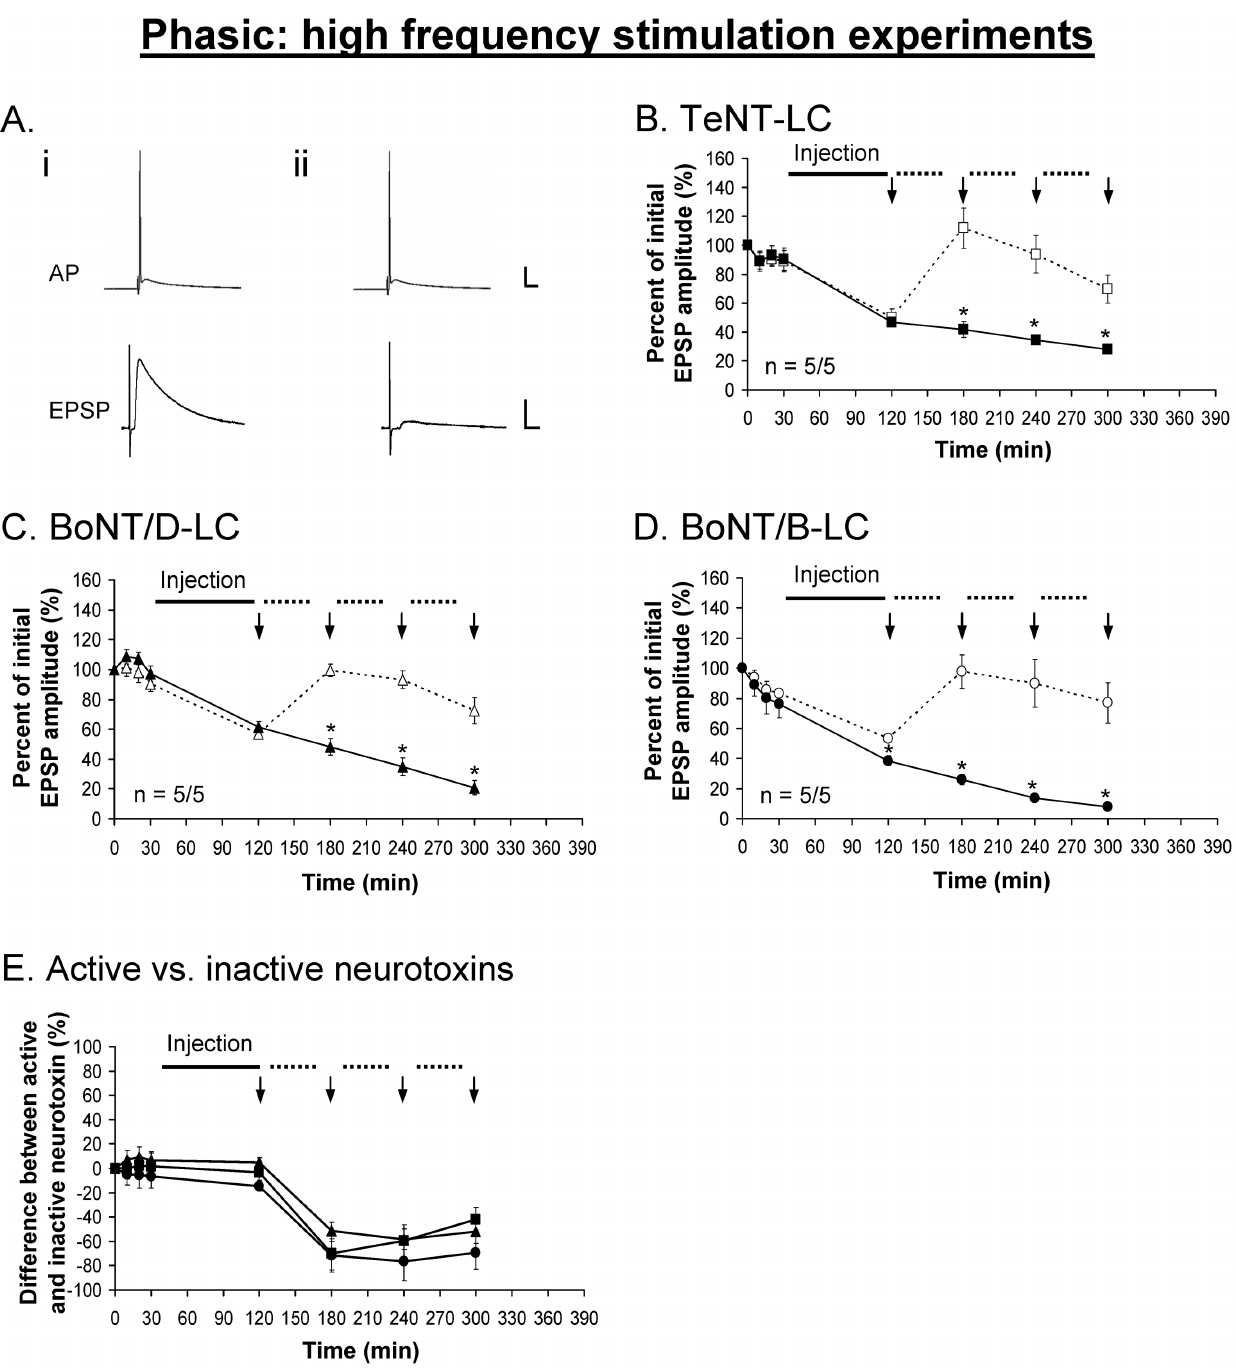
Figure 6. Phasic EPSPs are inhibited using TeNT-LC ( B ), BoNT/D-LC ( C ) and BoNT/B-LC ( D ) under high frequency stimulation. A , Example showing the phasic action potential (AP) remains unchanged before ( i ) and after ( ii ) the injection of each neurotoxin (BoNT/B-LC used as the example). E , Percent difference between active and inactive neurotoxin, in which the inactive neurotoxin is the reference point at 0%. In B-E, a solid black line represents the time course of neurotoxin injection (90 min), the dotted lines represent the time course of each round of high frequency N stimulation (40 min) and vertical arrows ( Q ) represent when EPSPs were recorded. Active neurotoxins: TeNT-LC ( & ), BoNT/D-LC ( m ) and BoNT/B-LC ). Inactive neurotoxins: TeNT-LC ( % ), BoNT/D-LC ( g ) and BoNT/B-LC ( # ). Error bars represent S.E.M. An asterisk (*) denotes a significant difference ( (p , 0.05) and ‘n’ represents sample size (active/inactive neurotoxin). Scale bars: horizontal – 10 ms; vertical – 10 mV (AP), 5 mV (EPSP). doi:10.1371/journal.pone.0095130.g006 evoke minimum synaptic activity to study the zippered state of the In addition, the low frequency of spontaneous release from the SNARE complex under resting state, which cannot be determined crayfish phasic and tonic terminals ( , 2–4 quanta/min, [21], [41]) with high frequency stimulation due to rapid turnover of SNAREs. reflects a low rate of turnover of the SNAREs, further contributing